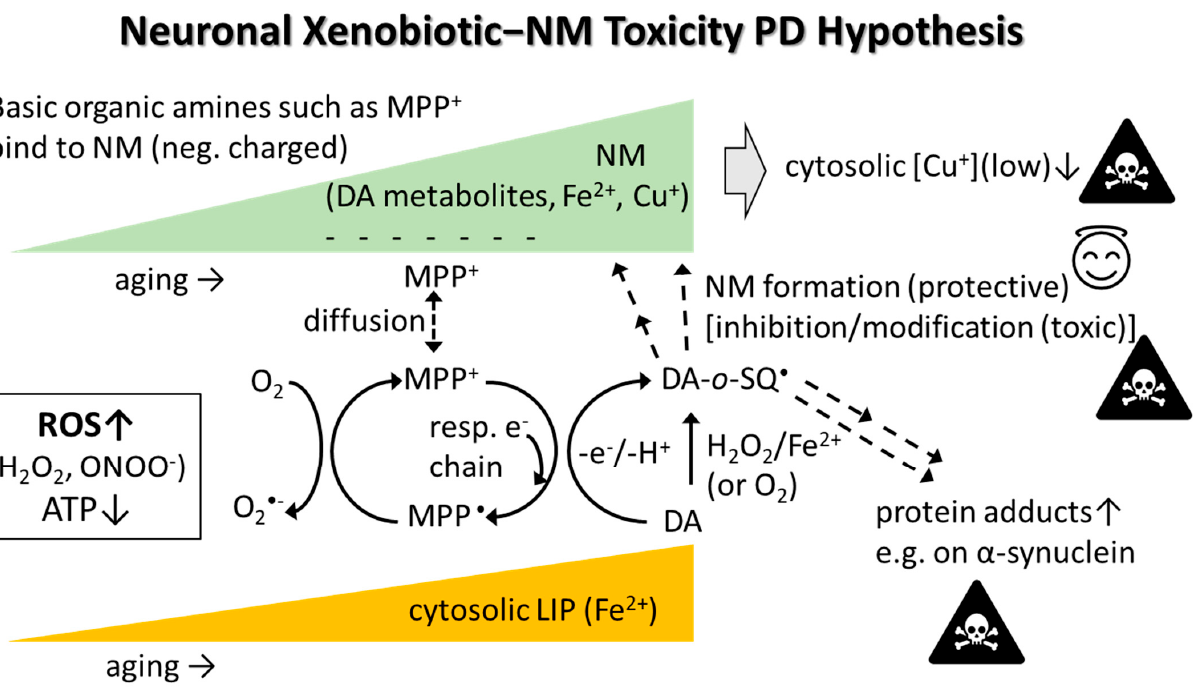
Figure 2. The neuronal xenobiotic-neuromelanin (NM) toxicity PD hypothesis. Negatively charged NM in SN attracts metal ions and positively charged xenobiotics such as basic organic amines (e.g.,